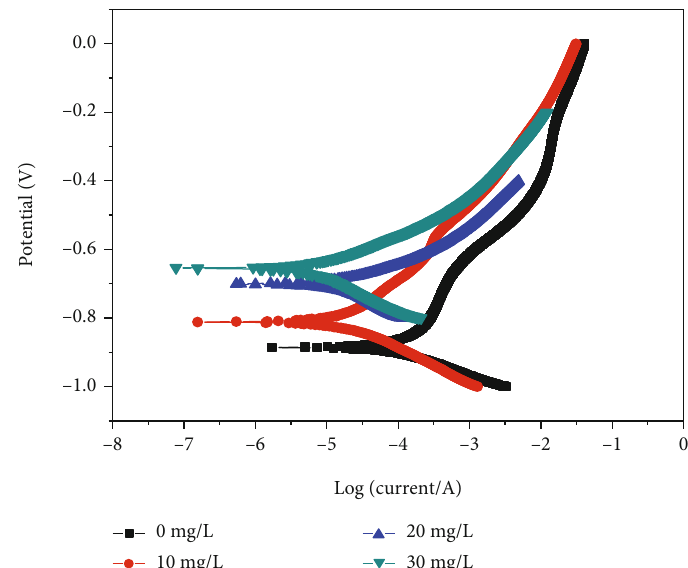
Figure 12: Polarization curves of carbon steel electrode in 3.5% NaCl solution with di ff erent concentrations of thiourea-modi fi ed polyepoxysuccinic acid (CNS-PESA).